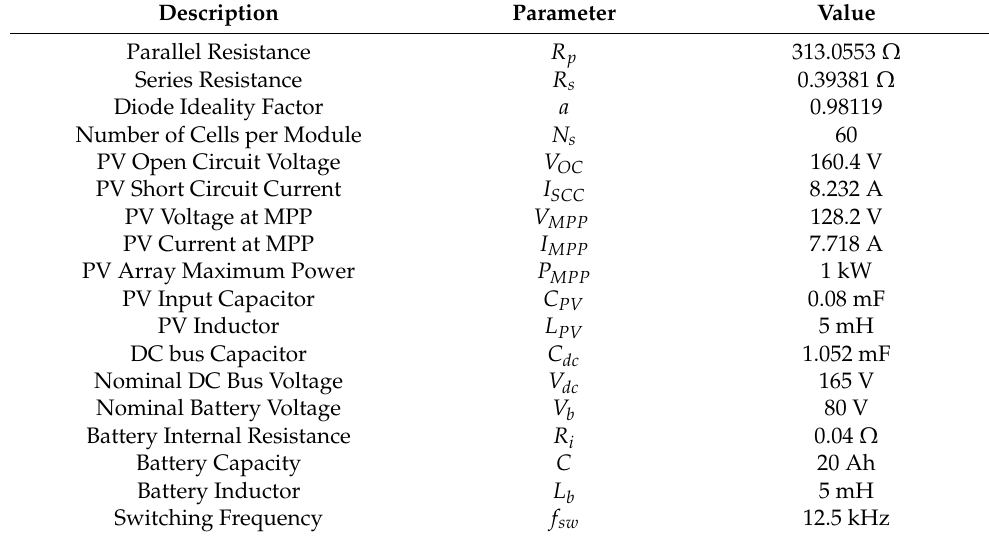
Table 1. Simulation